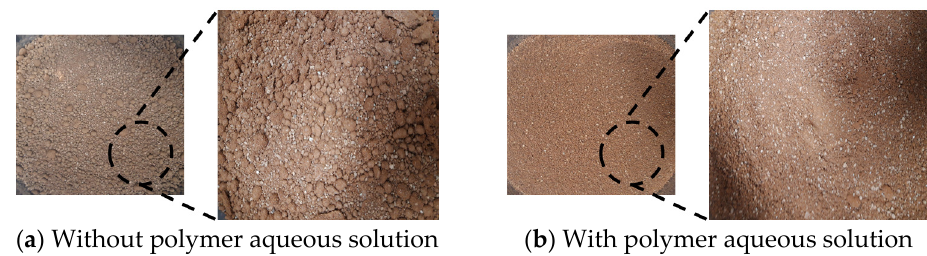
Figure 5. Surface changes of red clay binder with and without the polymer aqueous solution.